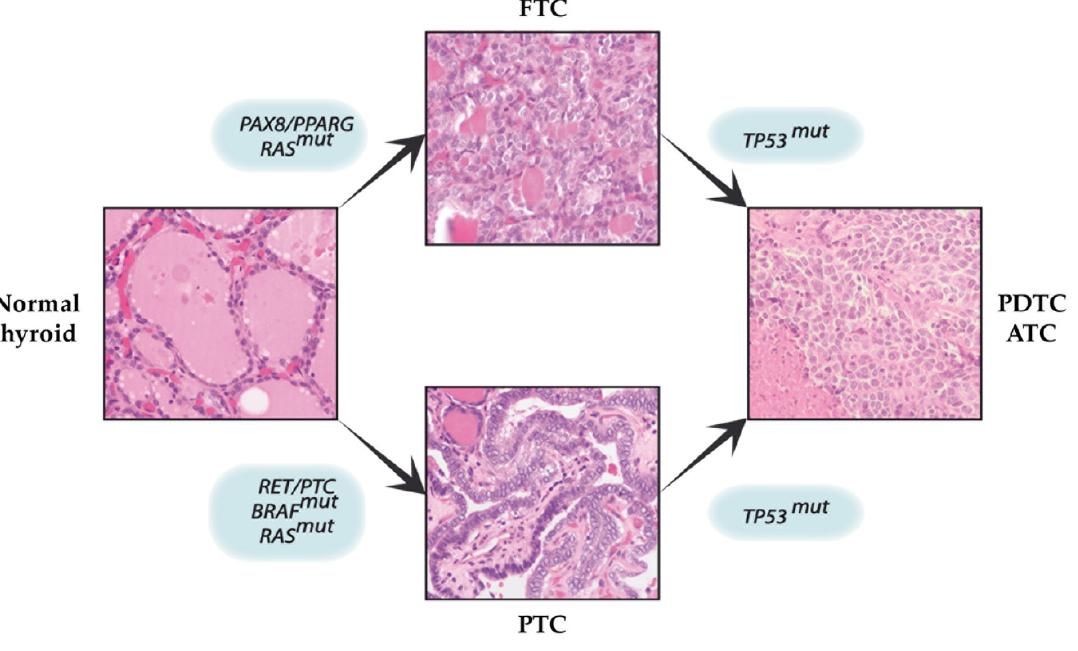
Figure 1. Schematic representation of multistep carcinogenesis in thyroid cancer. This model suggests a stepwise dedifferentiation process from mature thyroid cells, to well-differentiated cancer, up to poorly differentiated and anaplastic thyroid cancer, as the result of progressive accumulation of somatic genetic alterations (H&E stain, original magnification: 200×). Abbreviations: FTC = follicular thyroid cancer, TP53 = tumor protein p53, PAX8/PPARG = paired box 8/peroxisome proliferator-activated receptor gamma fusion protein, RAS mut = rat sarcoma viral oncogene homolog mutations, RET/PTC = rearranged during transfection/papillary thyroid carcinoma fusion protein, BRAF mut = v-raf murine sarcoma viral oncogene homolog B1 mutations, PTC = papillary thyroid cancer, TP53 mut = tumor protein p53 mutations, PDTC = poorly differentiated thyroid cancer, ATC = anaplastic thyroid cancer, H&E stain = hematoxylin and eosin stain.